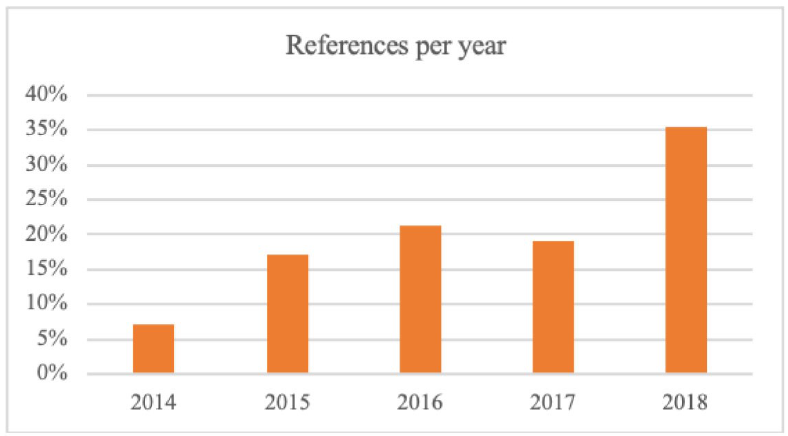
Figure 1. Time evolution of